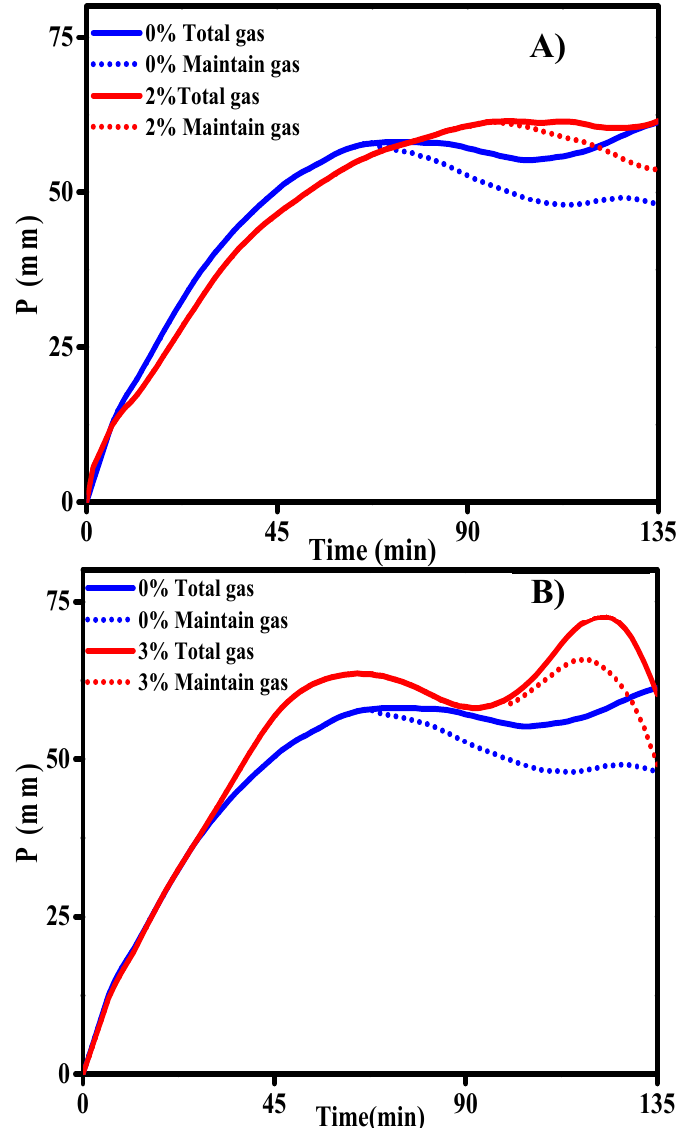
Figure 2. Dough fermentation curves of the 2.0 wt% α -CD and control groups ( A ) and 3.0 wt% γ -CD and control groups ( B ). Fermentation curves were obtained using the F4 fermentation rheometer. The solid line represents the total gas production and the dashed line represents the retained gas volume.